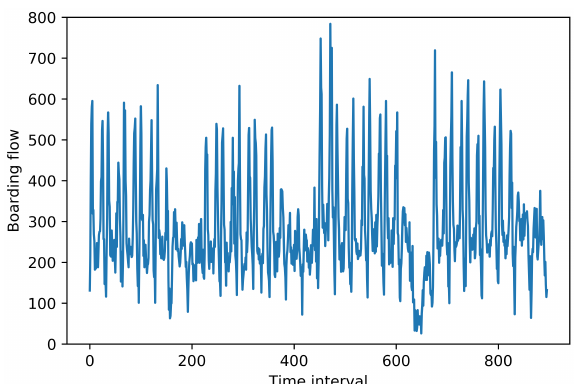
Figure 3. One week’s boarding flow in a region.